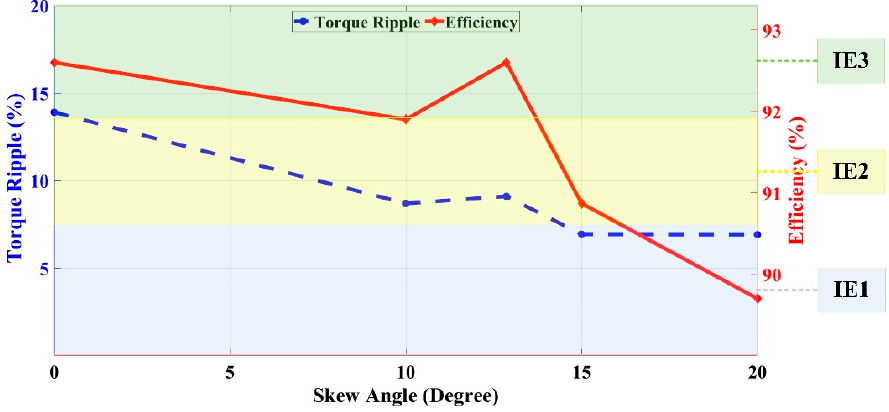
Figure 6. Efficiency and torque results of AFIM with 28 slots.